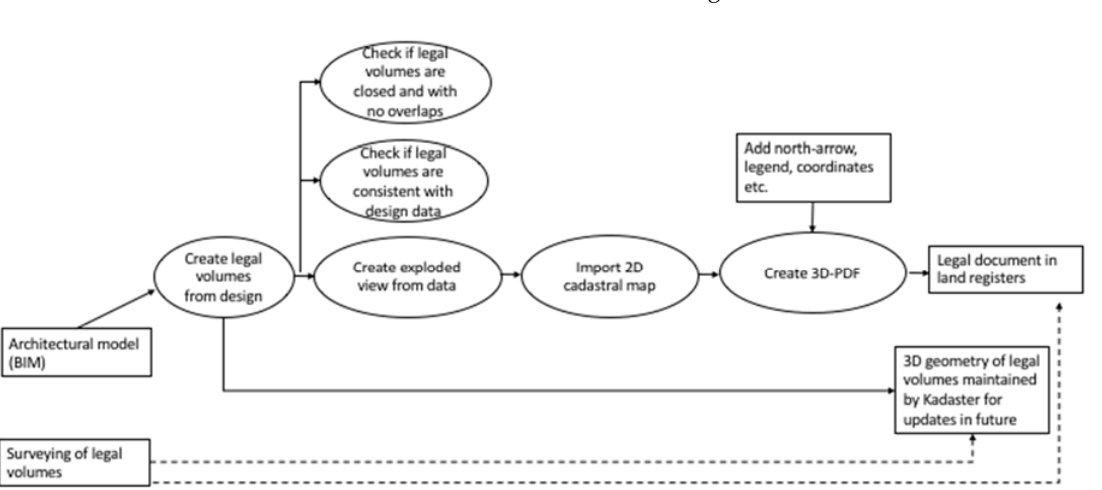
Figure 10. Schematic overview of a workflow to create a 3D PDF visualising a multi-property situation to be registered as a legal document in the land